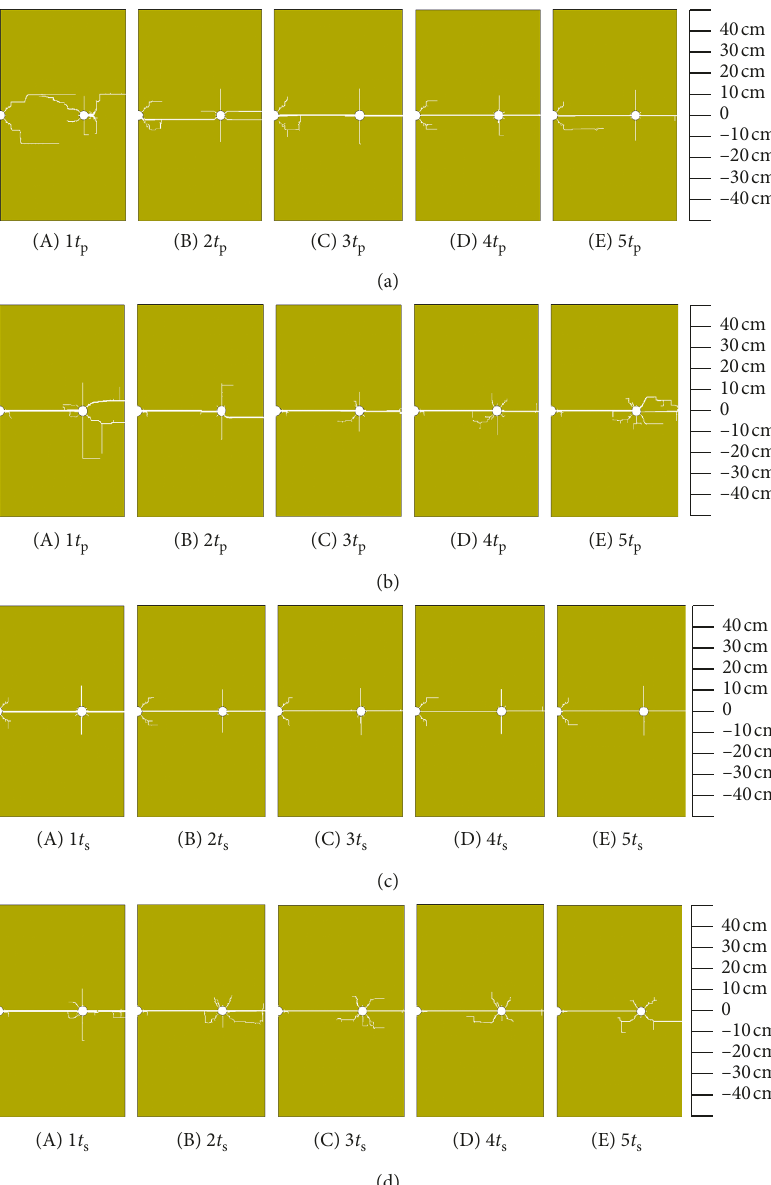
Figure 10: Crack formation diagram for different PBH shapes and different delay time. (a) The PBH is a round hole, different longitudinal wave multiples. (b) The PBH is a notch hole, different longitudinal wave multiples. (c) The PBH is a round hole, different transverse wave multiples. (d) The PBH is notch hole, different transverse wave